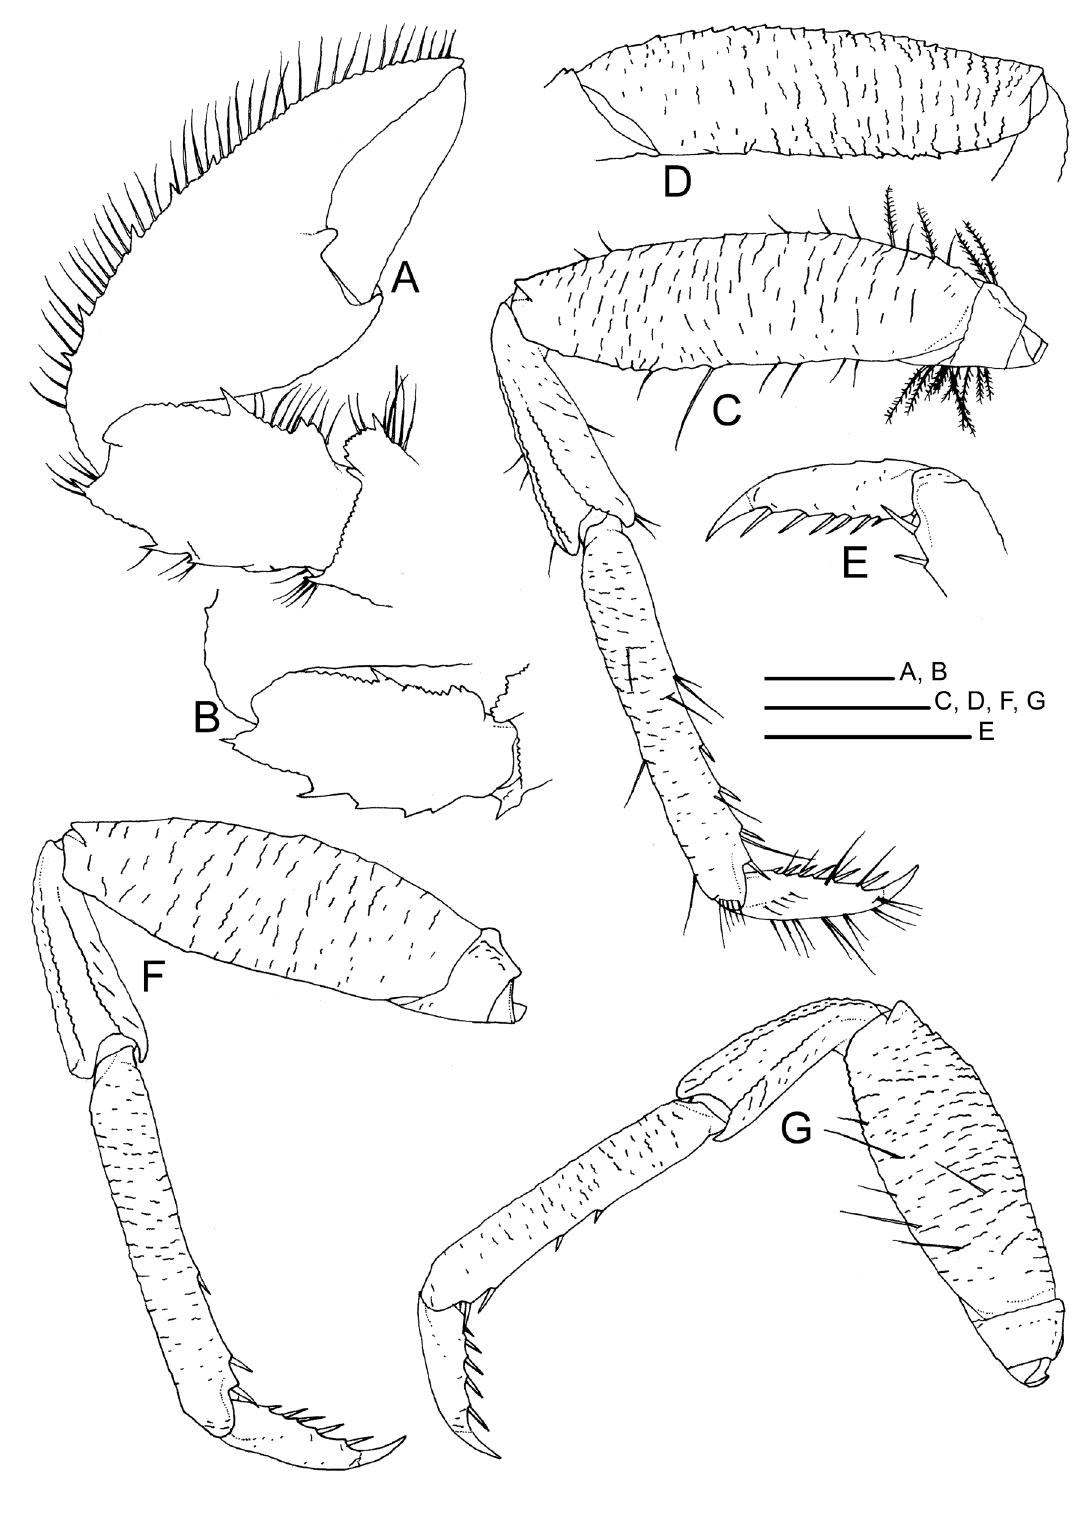
Figure 4. Enosteoides turkayi n. sp. Paratype, female (cl 3.6 mm), ZRC 2016.0063, Balicasag Island, stn T29 (A, B); holotype, female (cl 4.5 mm), NMCR, Balicasag Island (C–G). A, left cheliped, dorsal view (plumose setae simplified); B, same, carpus and distal part of merus, dorso-anterior view; C, left second pereopod, lateral view; D, same, merus, mesial view; E, same, dactylus and distal part of propodus, lateral view; F, left third pereopod, lateral view (setae on margins omitted); G, left fourth pereopod, lateral view (setae on margins omitted). Scale bars = 1.0